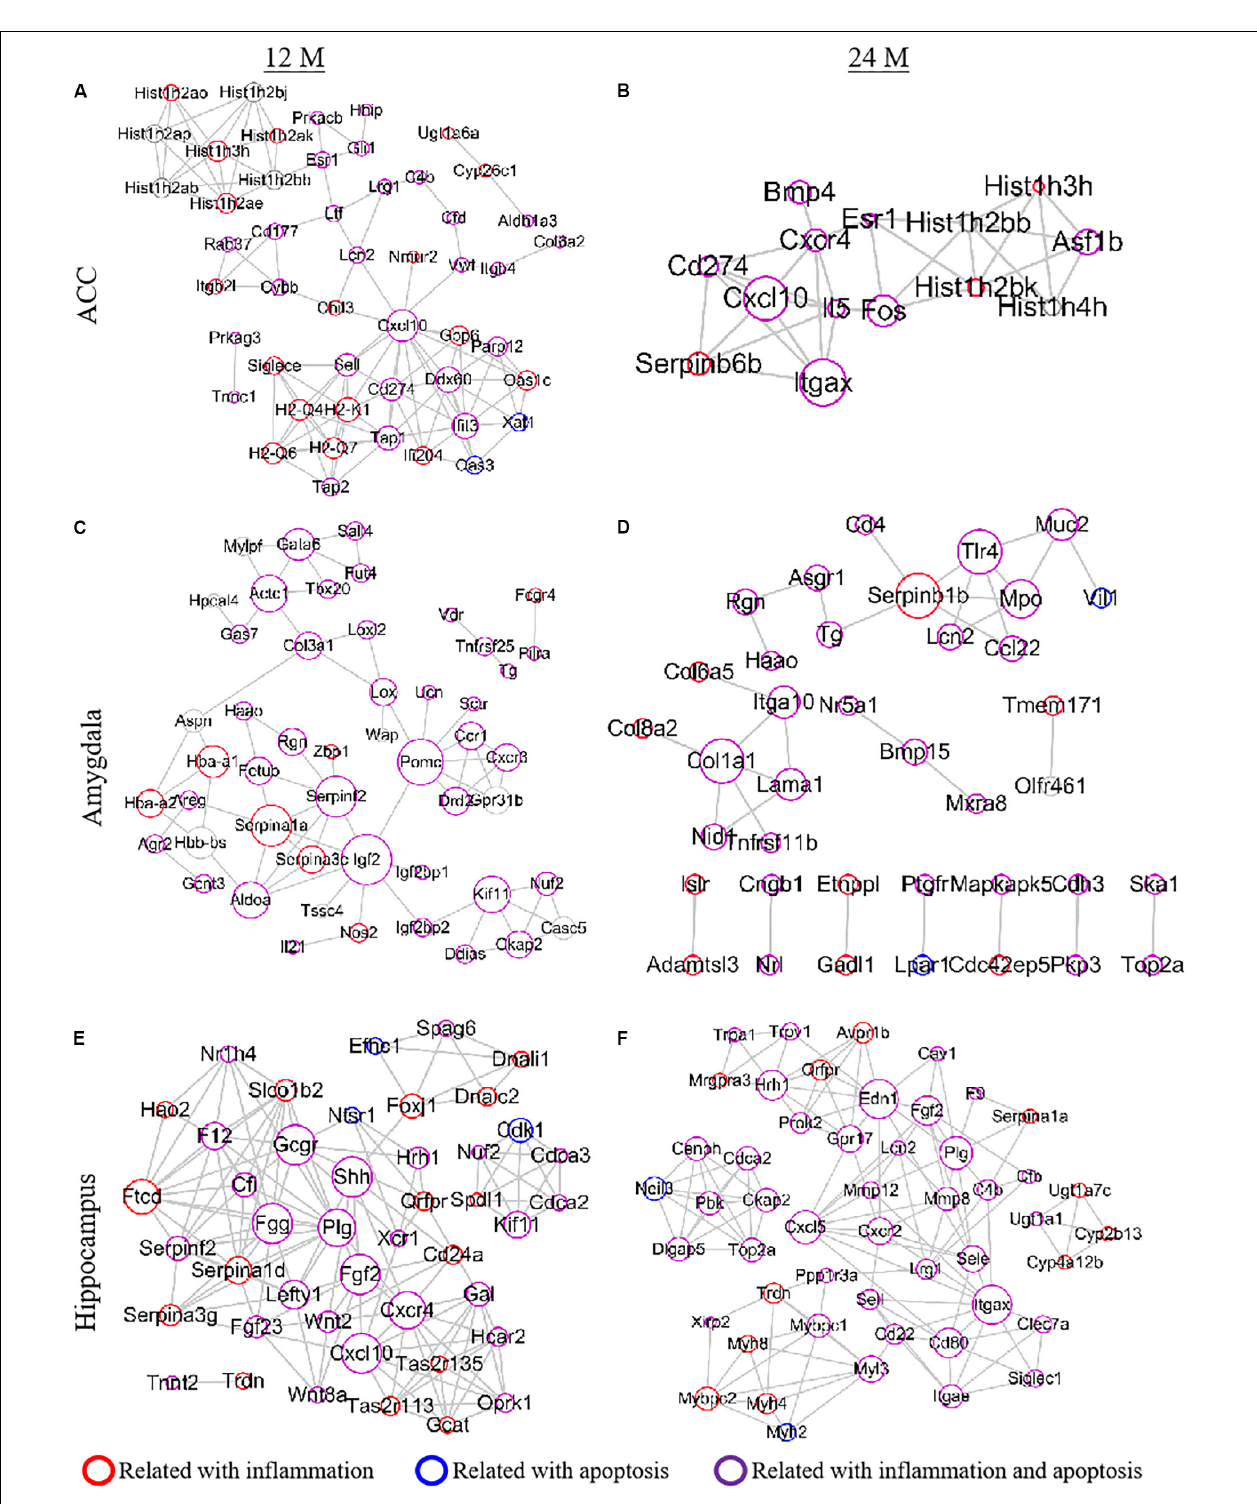
FIGURE 8 | Establishment of a PPI network to analyze protein-protein interactions. Top 50 differentially expressed genes (DEGs) were selected according to the connection degree of genes in the ACC (A,B) , amygdala (C,D) , and hippocampus (E,F) of 12- (A,C,E) and 24- (B,D,F) month old mice. The size of the node is determined by the connection degree. The connection degree reflects the importance of the gene in the network as it represents the number of nodes connected. The red, blue, and purple circles represent the genes related to inflammation, apoptosis and both inflammation and apoptosis, respectively.